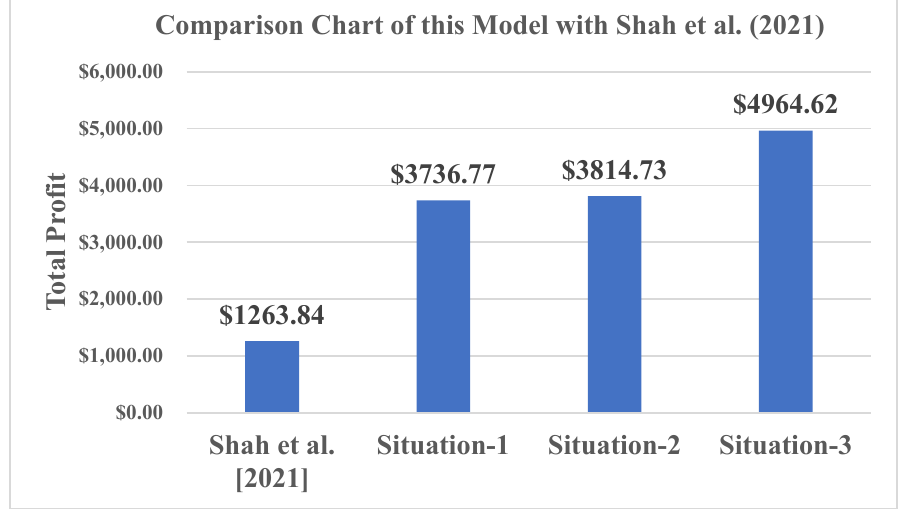
15 of 22 Figure 4. Optimality of a total profit function for situation 3 ( 0